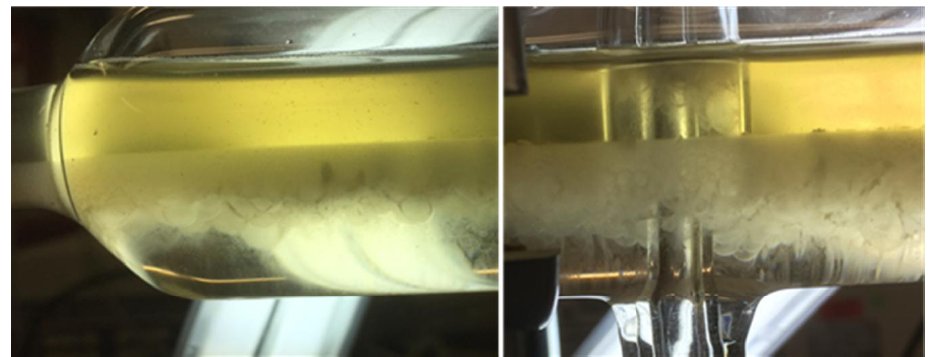
Figure 14. Side view of the laboratory settler (DN35, 175 mL hold-up. DN: diameter nominal) during continuous settling operation (300 s residence time). The image shows the inlet area ( left ) and the heavy phase outlet ( right ).